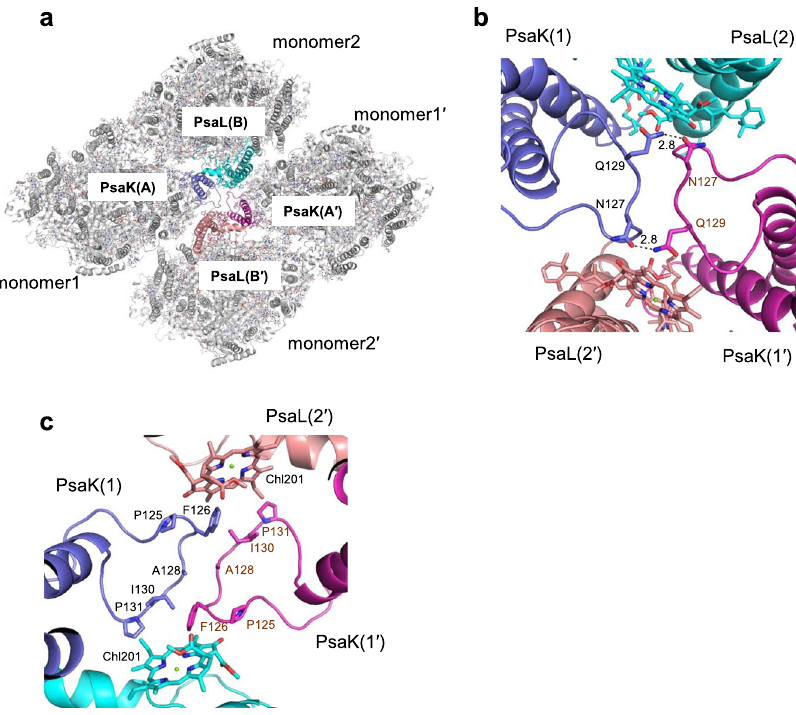
Fig. 5 Interactions at the center of the PSI tetramer. a Structures of the PSI tetramer viewed along the membrane normal from the stromal side. b , c Interactions among monomer1-PsaK, monomer2-PsaL, monomer1 ′ -PsaK, and monomer2 ′ -PsaL, viewed along the membrane normal from the stromal side ( b ) and viewed from the inner side of the membrane to the stromal side ( c ).